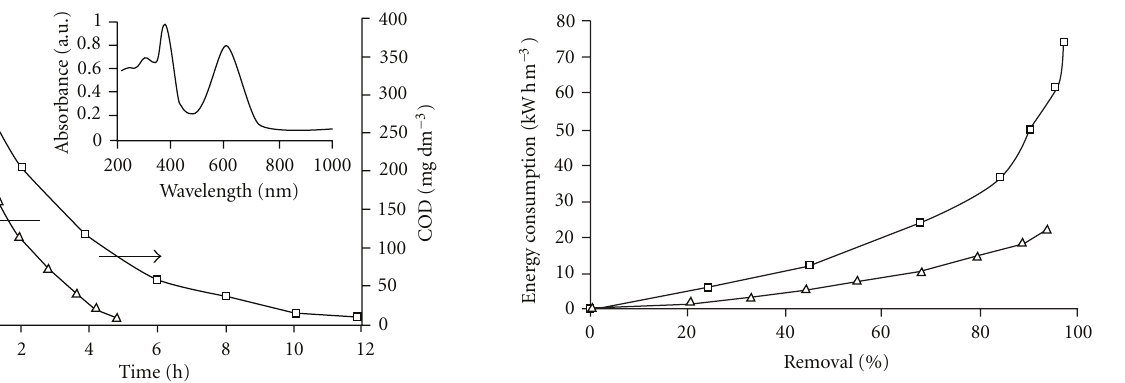
Figure 6: Trend of absorbance band at 594 nm ( (cid:5) ) and COD ( (cid:3) ) during the anodic oxidation solution of acid blue 22 at a 0.3 mM concentration on the BDD electrode at i = 20mAcm − 2 , flow rate = 300dm 3 h − 1 , T = 25 ◦ C. UV spectrum of the acid blue 22 is shown in the inset [24].